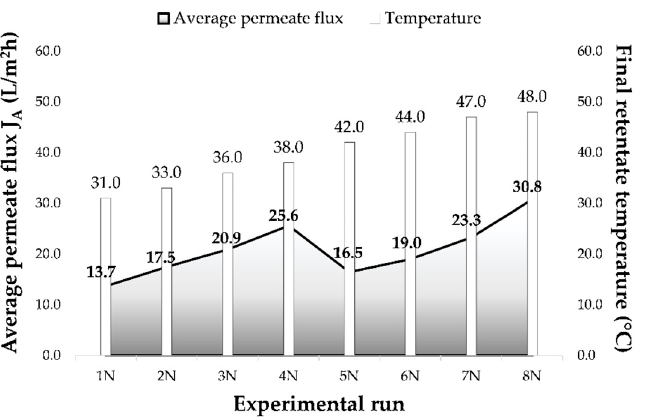
Figure 1. Influence of applied pressure on the average permeate flux J A (L/m 2 h) and final retentate temperature (°C) during nanofiltration process of conventional and ecological Cabernet Sauvignon